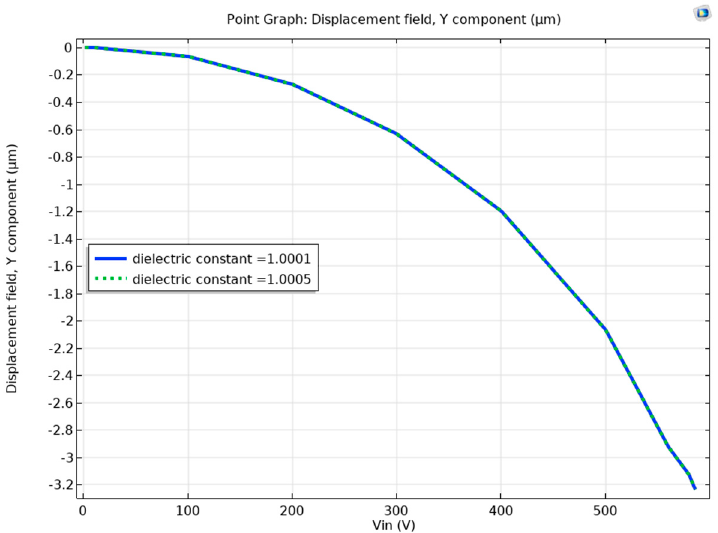
Figure 4. Displacement behavior of the tip of the beam without electrical resonance. Subjected to DC voltage ramping (1–586 V) which showed no visible displacement di ff erence at ε of 1.0001 and 1.0005.